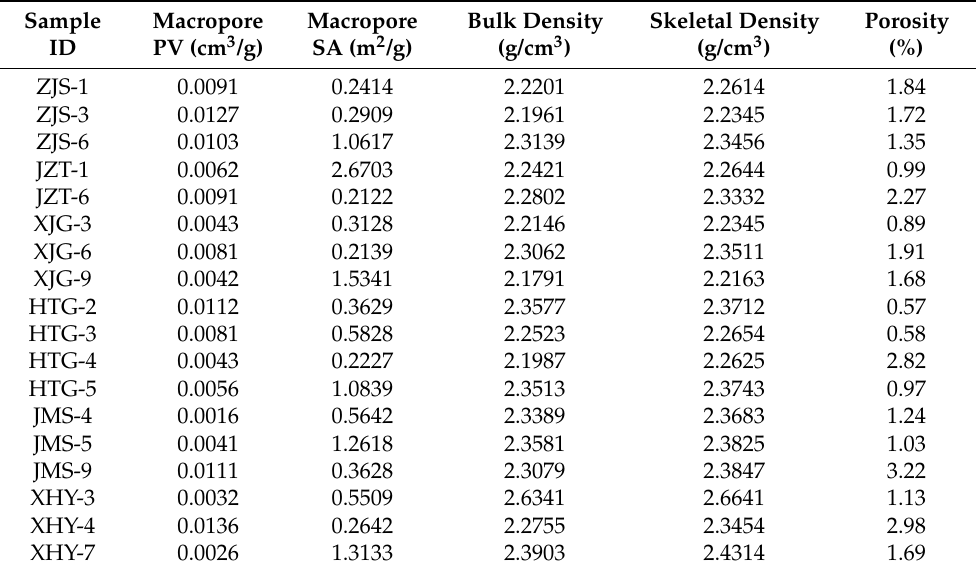
Table 2. MIP measurement results of the Mesoproterozoic Xiamaling shale in Zhangjiakou,